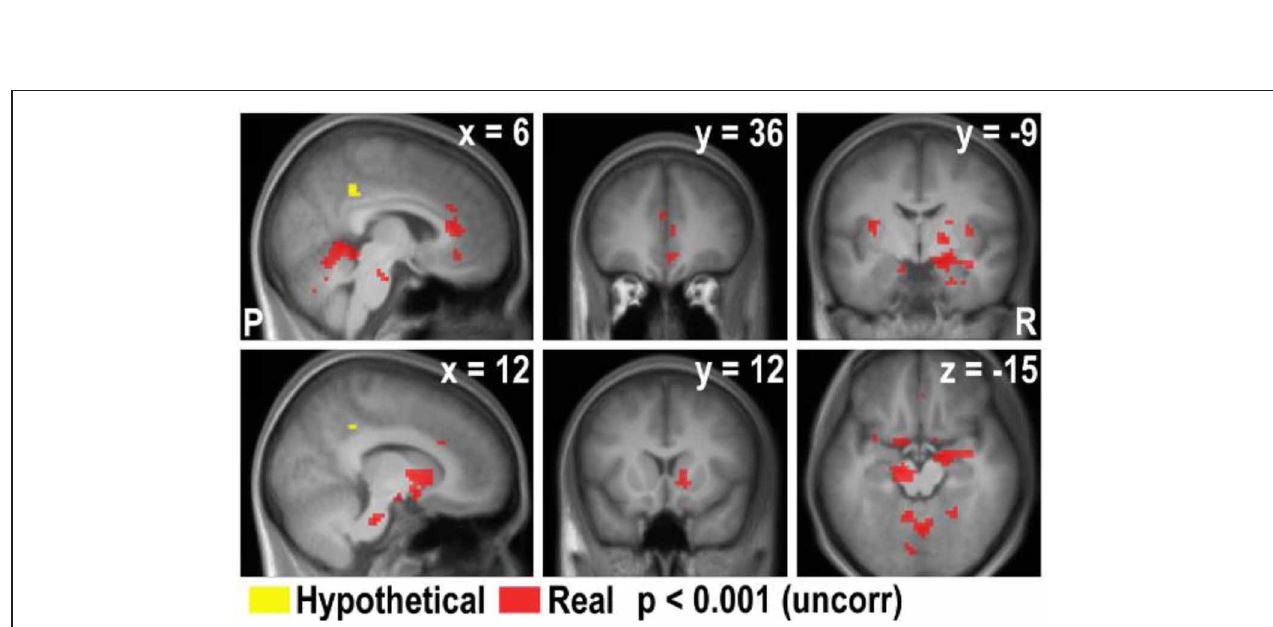
FIGURE A3 | Overlay of the areas exhibiting negative correlation with bids in real and hypothetical trials (overlay of the real × bid and hypothetical × bid